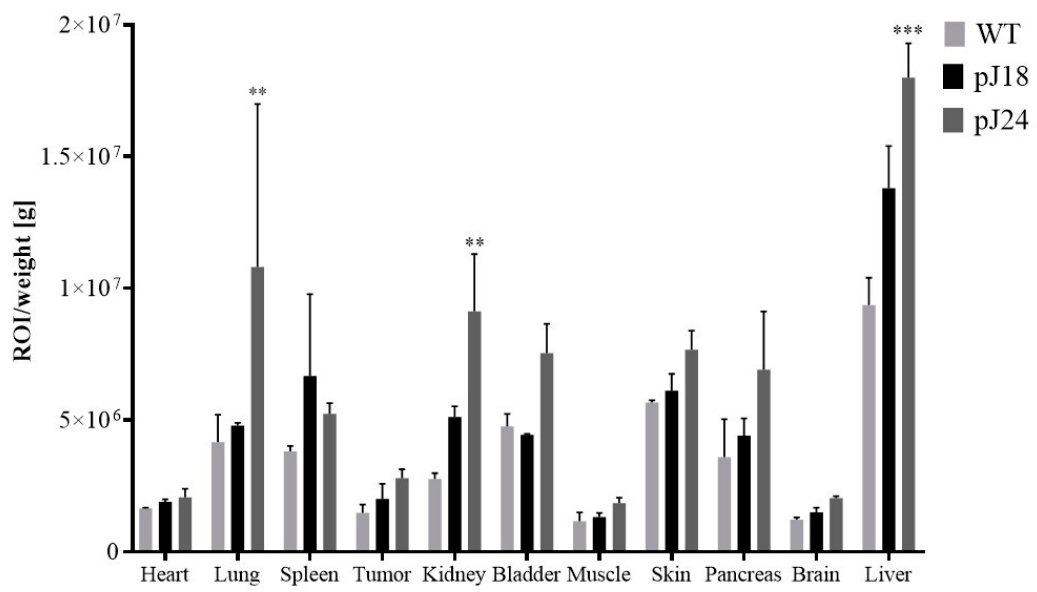
Figure 5. Biodistribution of AF680-labeled pJ18, pJ24, and WT phage in SKOV-3 xenografted nude female mice. Mice ( n = 2) were injected with 10 12 virions of phage. After 4 h the animals were sacrificed, and the organs, tissues, and tumors were excised and weighed. The fluorescent intensity was measured using a Xenogen IVIS 200 System. Fluorescent uptake was normalized to the weight of each organ and reported as fluorescent intensity per gram. Fluorescent intensity / g was significantly higher for pJ24 in the lungs, kidneys, and liver as compared to WT. A p -value of < 0.05 was considered significant. ** p < 0.01, *** p < 0.001.